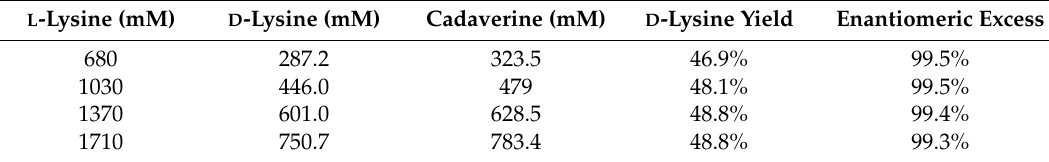
Table 1. The production of D -lysine from different concentration of L